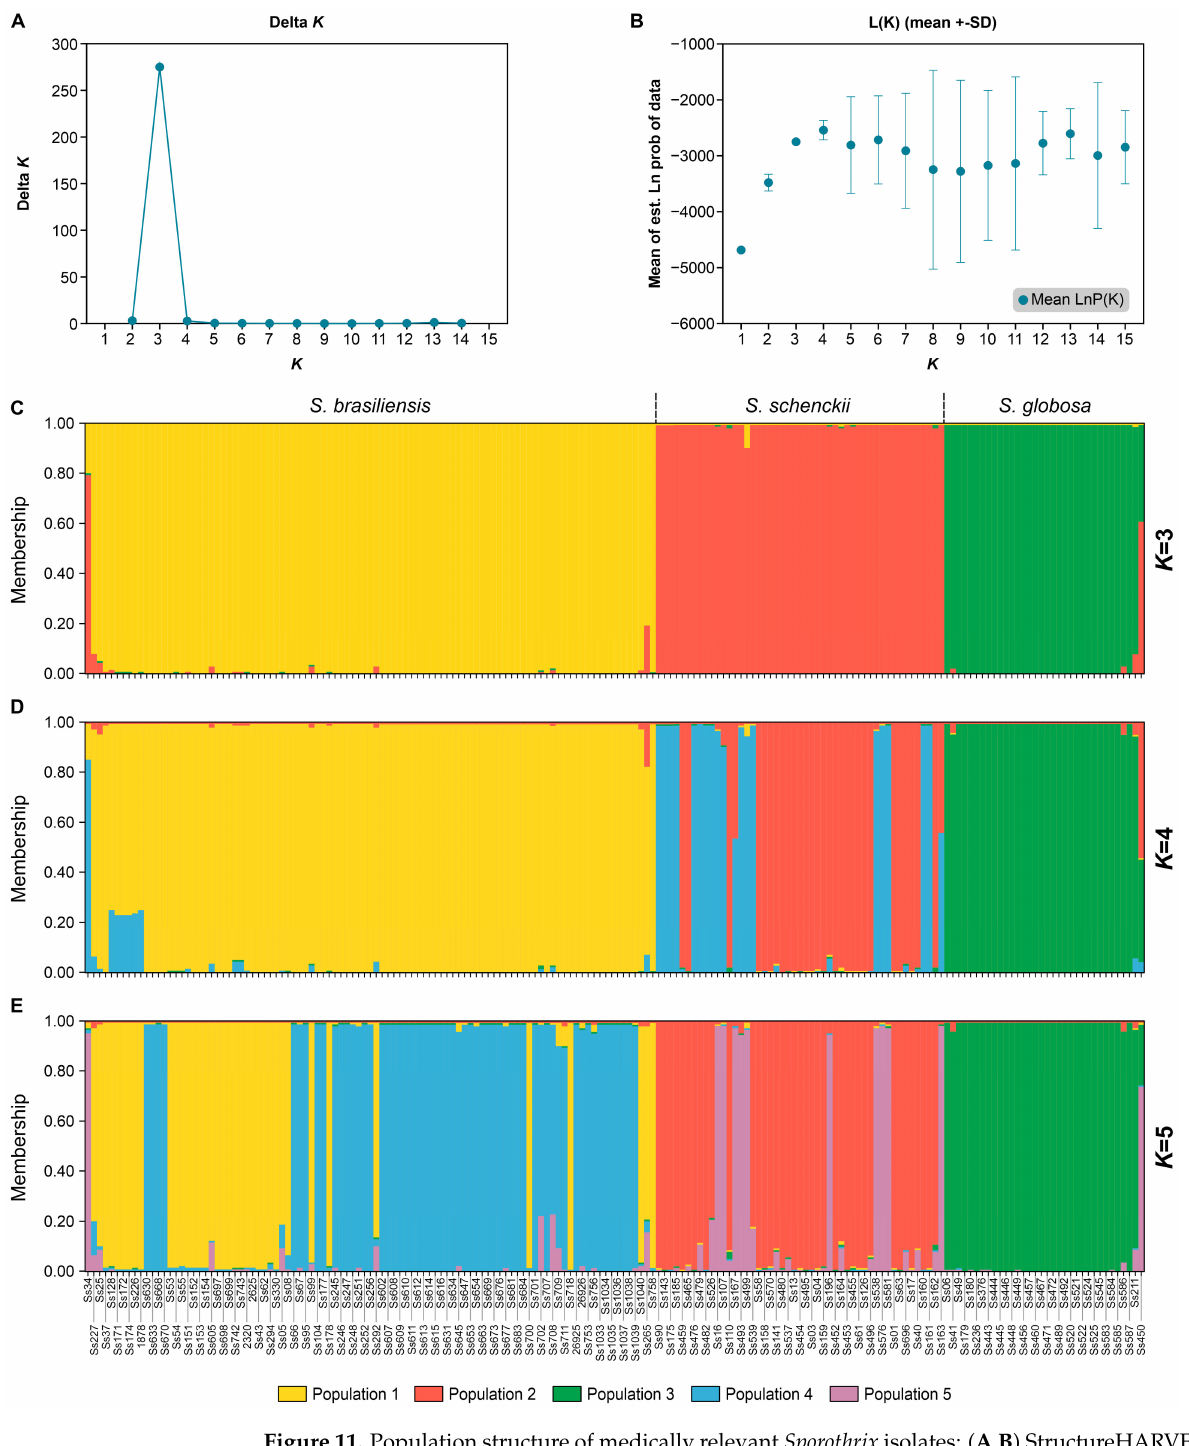
Figure 11. Population structure of medically relevant Sporothrix isolates: ( A , B ) StructureHARVESTER results show the most reasonable number of genetic clusters ( K ) within the complete data according to the approach described by Evanno et al. [68]. The population genetic structure of the estimated ∆ K value (275.005058) defined the maximum value at K = 3 and LnP (Mean LnP(K) = − 2749.95 ± 1.89). Bayesian cluster analyses with S TRUCTURE for ( C ) K = 3, ( D ) K = 4, ( E ) K = 5 based on SSR markers. Each vertical bar exemplifies one individual and its probability of being allocated to clusters. Further information about inferred ancestry can be found in Supplementary Table